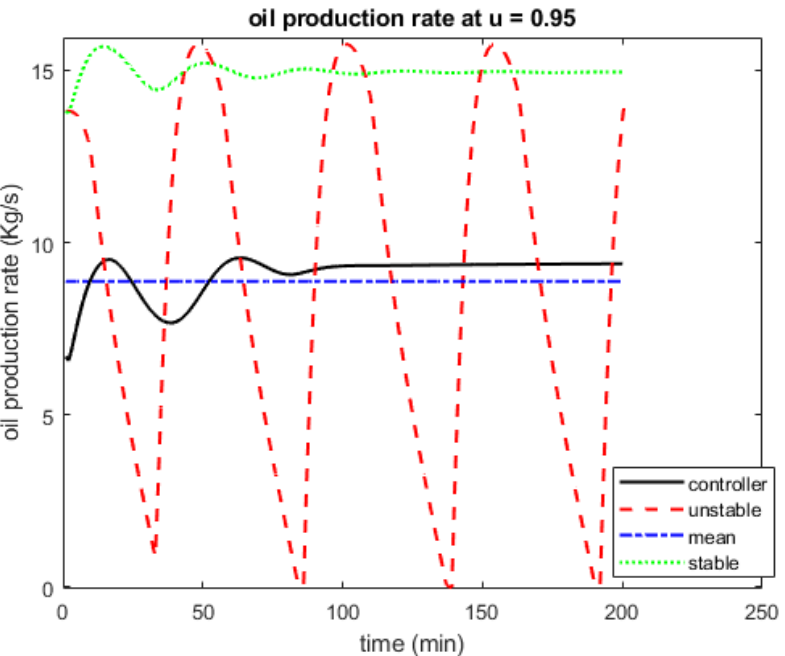
Figure 8. Oil production rate at 95% valve opening ( u = 0.95). The optimal production from the controller (black solid line), unstable production (red dashed line) and mean production (blue dash- dotted) were obtained at GOR = 0.01, while the stable production (green dotted line) was obtained at GOR = 0.4.